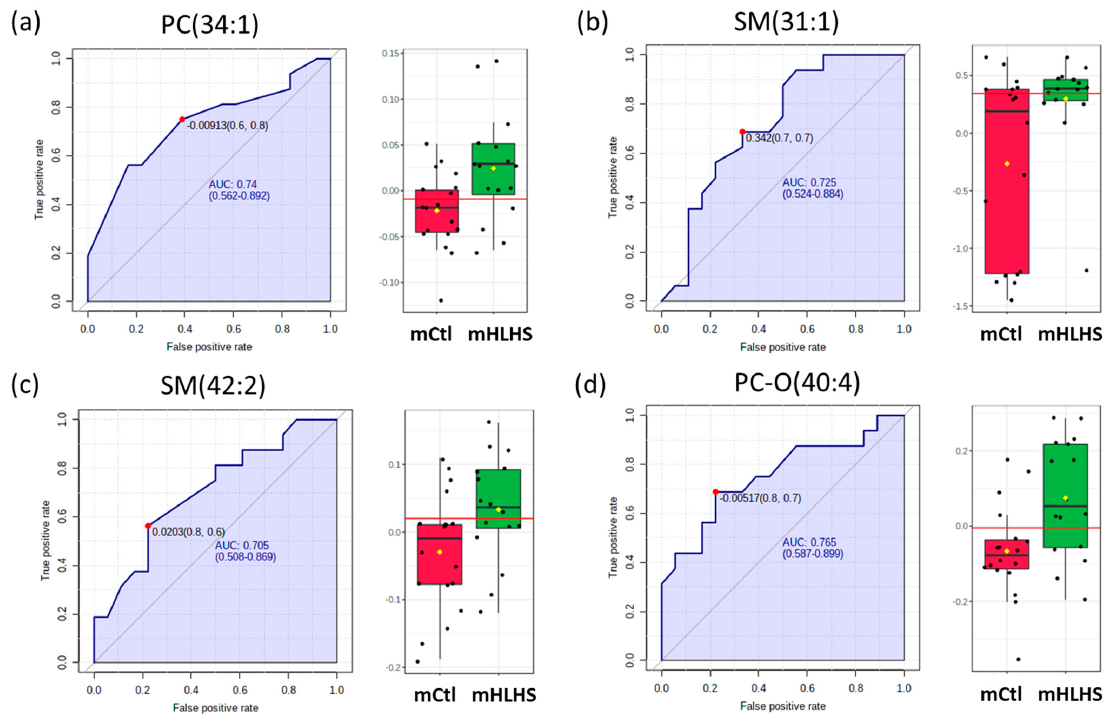
Figure 5. Biomarker analysis for the predictive values metabolites for mHLHS. The sensitivity (true positive rate) is on the y -axis, and the specificity (one minus the false positive rate) is on the x -axis, with the area under the curve (AUC) > 0.70 on four metabolites, including ( a ) PC (34:1), ( b ) SM (31:1), ( c ) SM (42:2) and ( d ) PC-O (40:4). A horizontal line in red in the box plots indicates the optimal cutoff of between two groups.